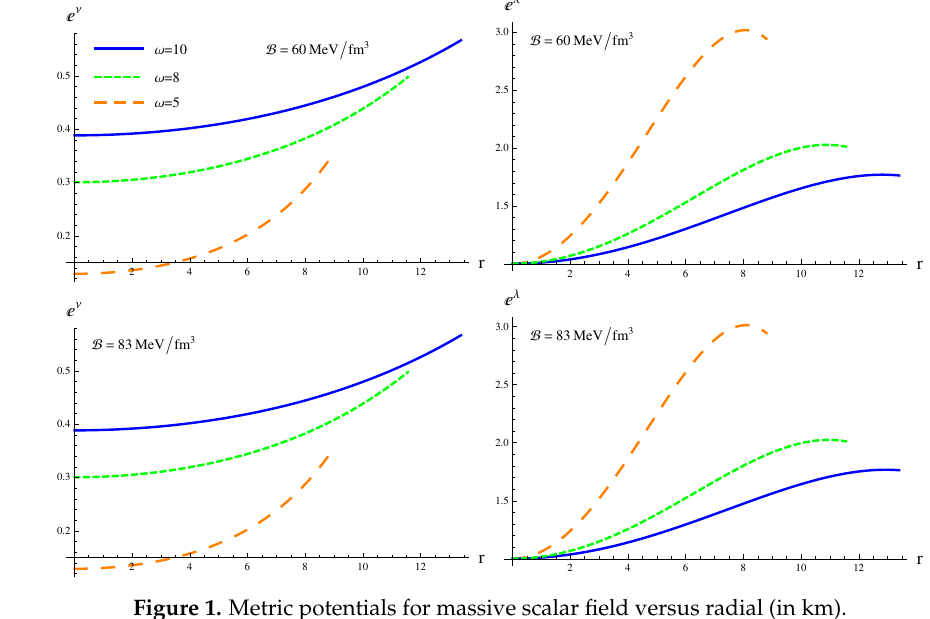
Figure 1. Metric potentials for massive scalar field versus radial (in km).